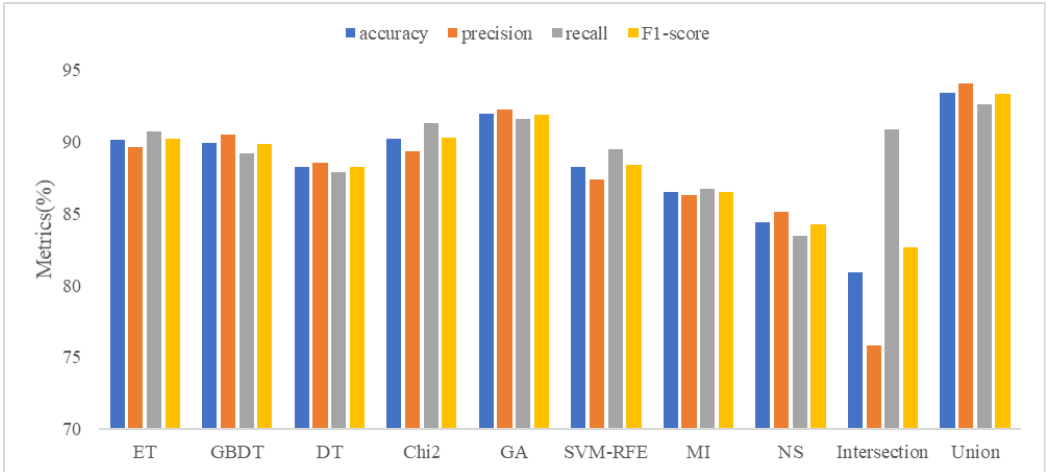
Sensors 2022 , 22 , x FOR PEER REVIEW Figure 7. Feature selection results comparison on OmniDroid dataset. Figure 7. Feature selection results comparison on OmniDroid dataset.